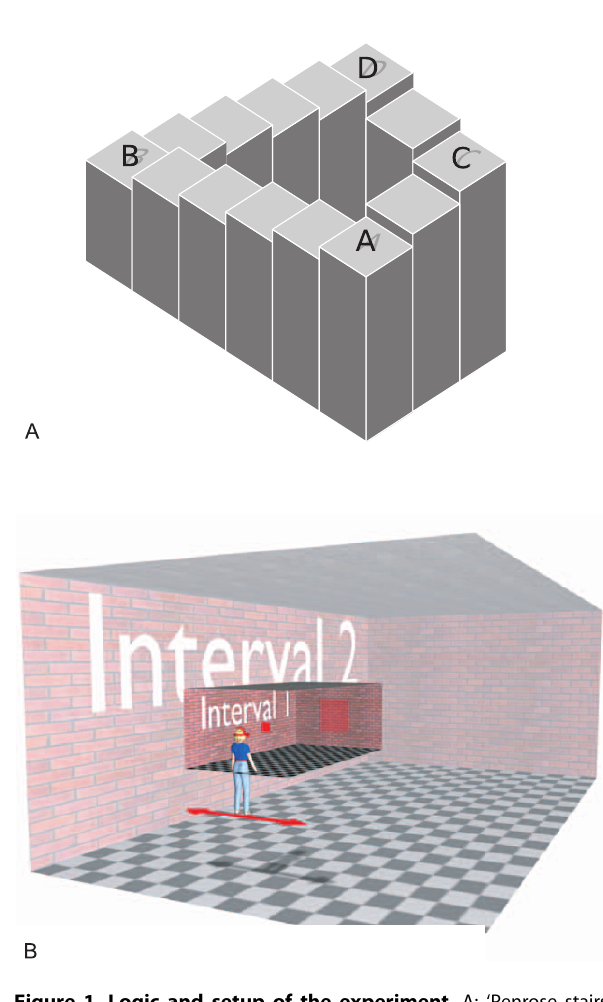
Participants viewed a square in interval 1 and compared its distance to that of a similar square displayed in interval 2 while rocking from side to side to enhance the motion parallax information. At the start of each interval, the squares were always the same angular size (5.7 deg), so this was not a useful cue to distance. The distance of the square in interval 1 was fixed for each condition and always displayed at eye height. Participants responded by pressing one of two buttons to indicate whether they perceived the square in interval 2 to be nearer or farther away than the reference square in interval 1. The distance of the square in interval 2 was varied from trial to trial according to a staircase procedure (see Materials and Methods) to establish the distance at which participants perceived the two squares to be at the same distance.